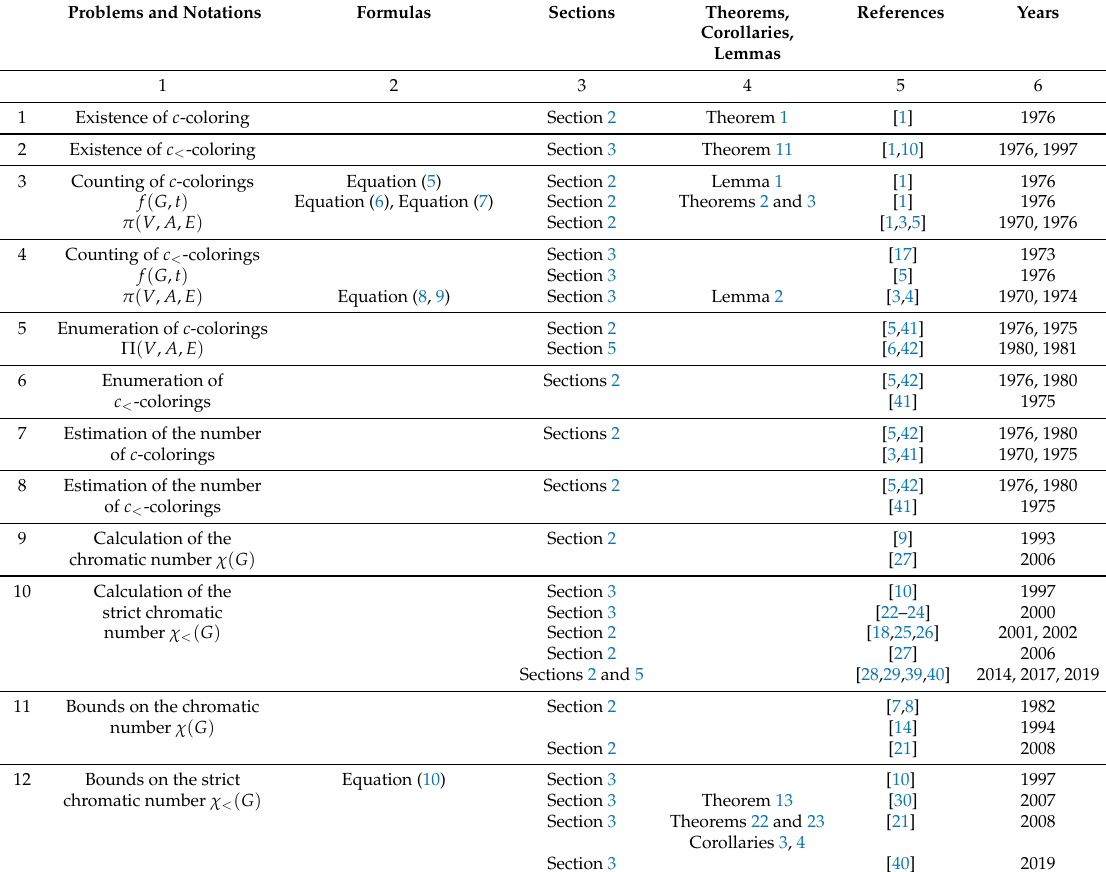
Table 3. Existence, estimation and enumeration of c -colorings and c < -colorings of the mixed